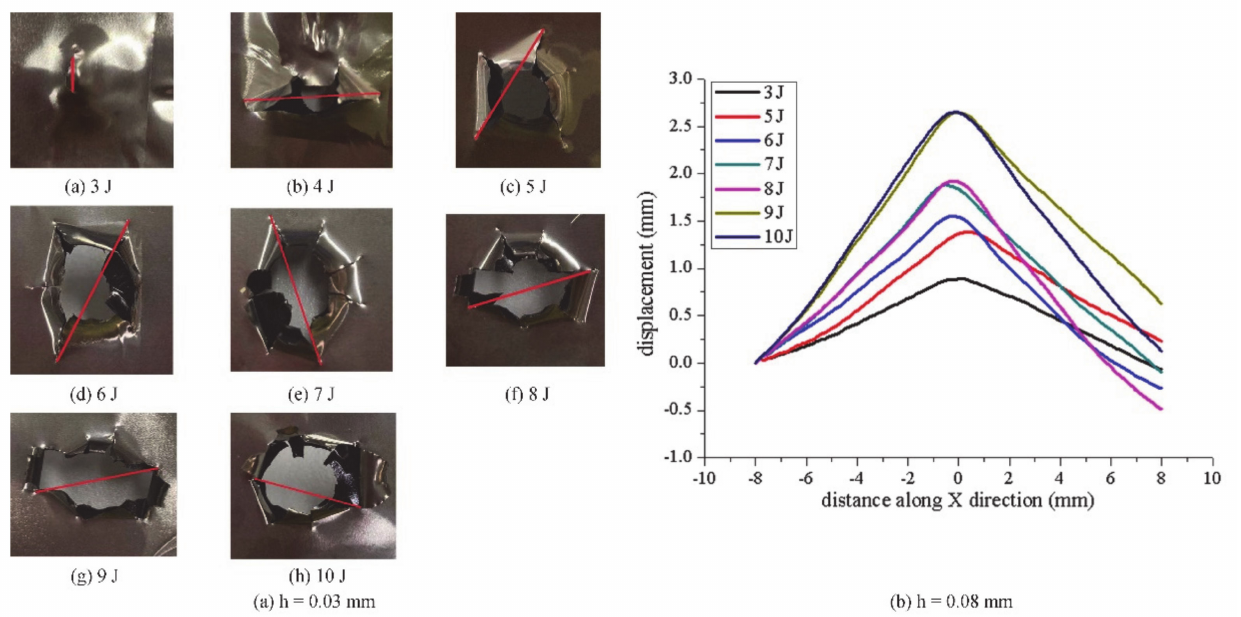
Figure 4. ( a ) The morphologies of target material with different energies. ( b ) The outline of targets with different